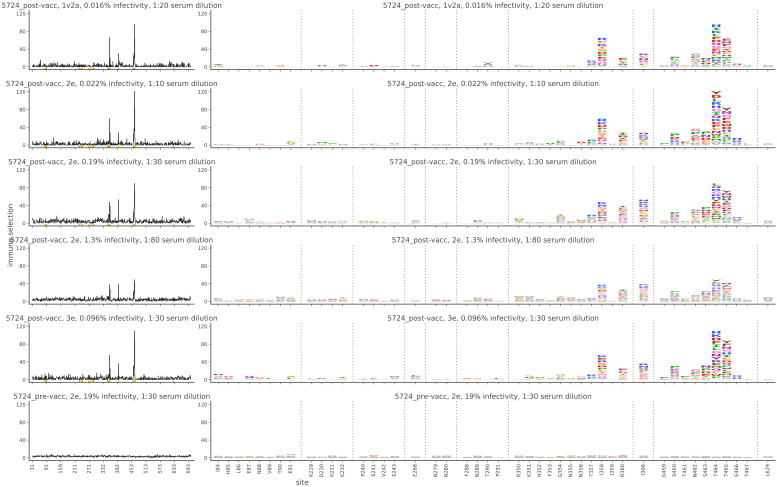
Mutational antigenic profiling data plotted for each individual replicates of pre- and post-immunization sera from rabbit 5724.Data are plotted as in Figure 2A,B for each, but with mutations colored according to their biochemical property rather than epitope.